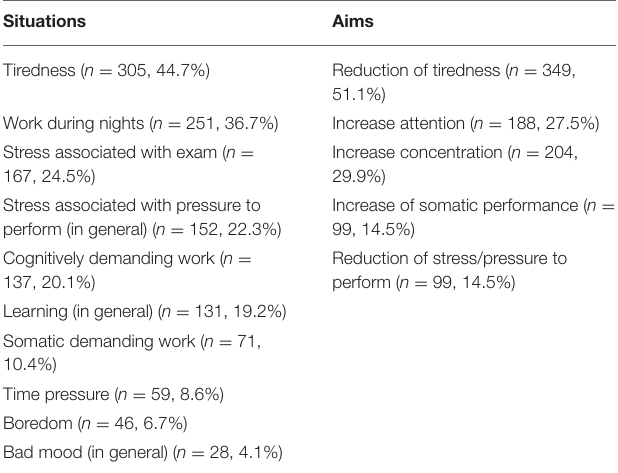
TABLE 6 | Situations and aims for the use of methylxanthines are used for neuroenhancement. Situations Aims